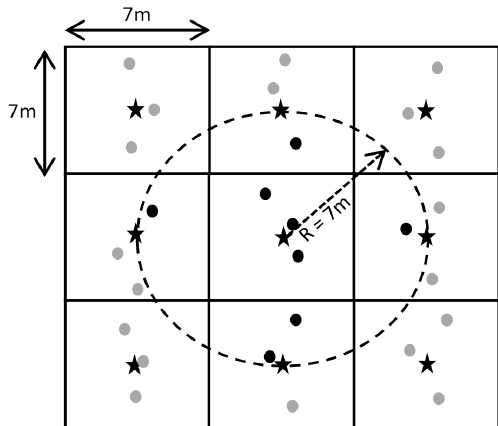
Figure 3. Interpolation of points on a 7 m × 7 m grid. Black stars indicate position of interpolated values at the nodes of a 7 m grid, dashed circle indicates an R-sphere with 7 m radius, black dots indicate positions of experimental data used to estimate the value of the central node, and grey dots indicate positions of experimental data beyond the R-sphere and not used.